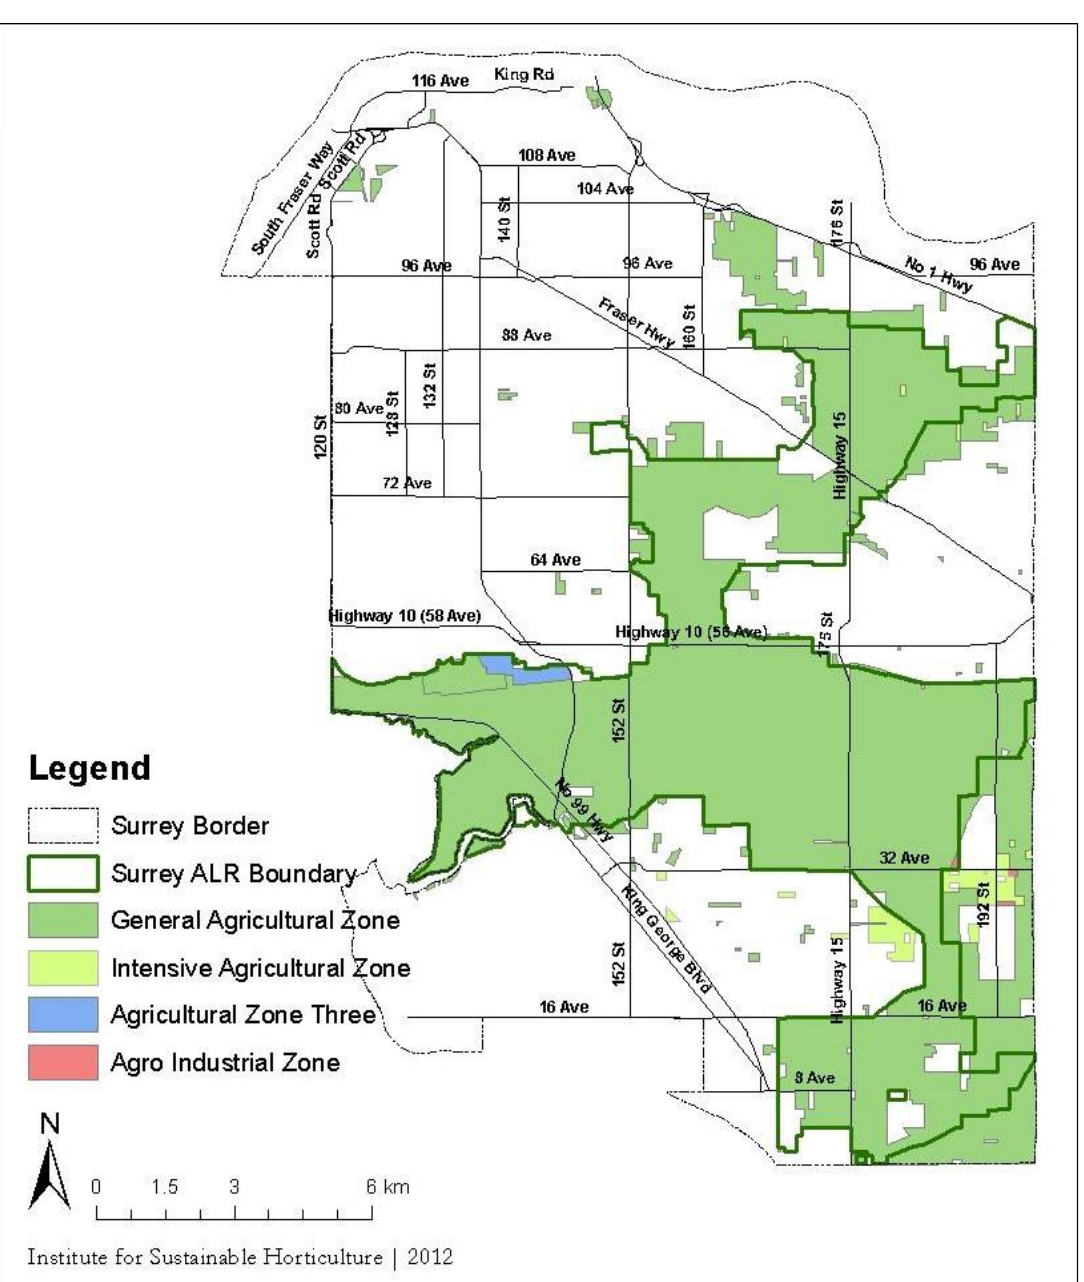
Figure 2. ALR Boundary and Municipal Agriculture Zones in Surrey,